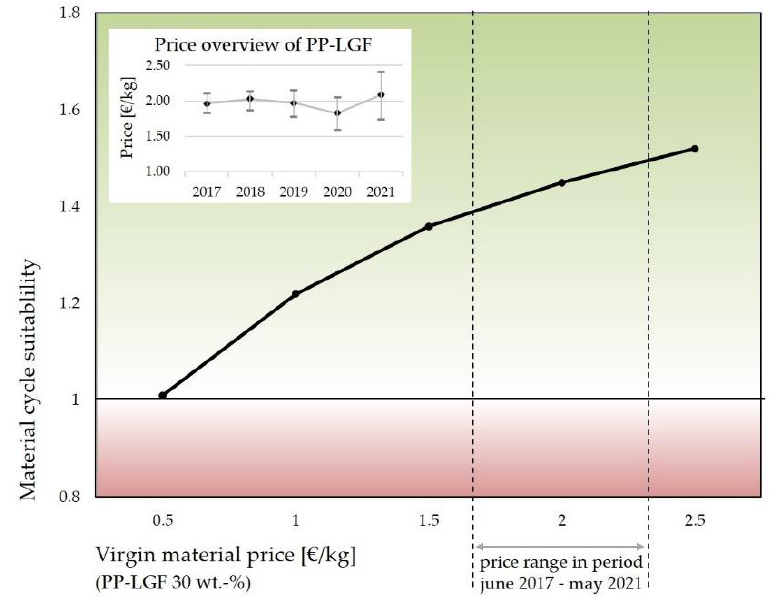
Figure 11. Material cycle suitability for material recycling of organo sheet offcut, which depends on the price of virgin material for PP-LGF (30 wt.-%)